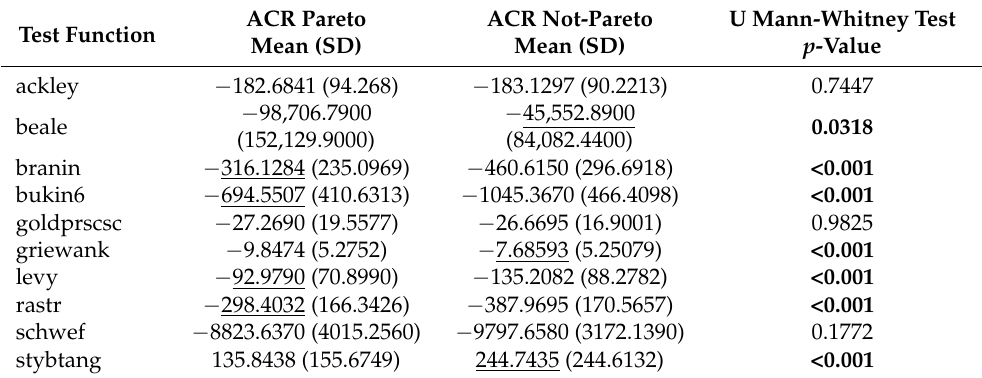
Table 2. ACR with respect to Pareto and Not-Pareto decisions, separately for each test function.